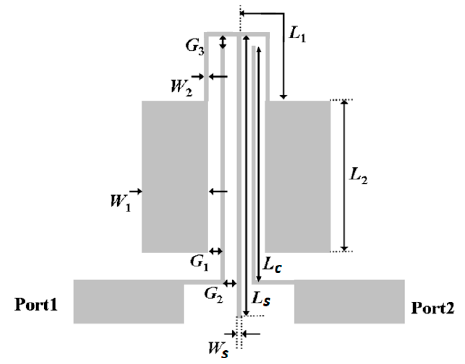
Figure 3. Structure of the ultra-wideband bandpass filter with a wide stopband.